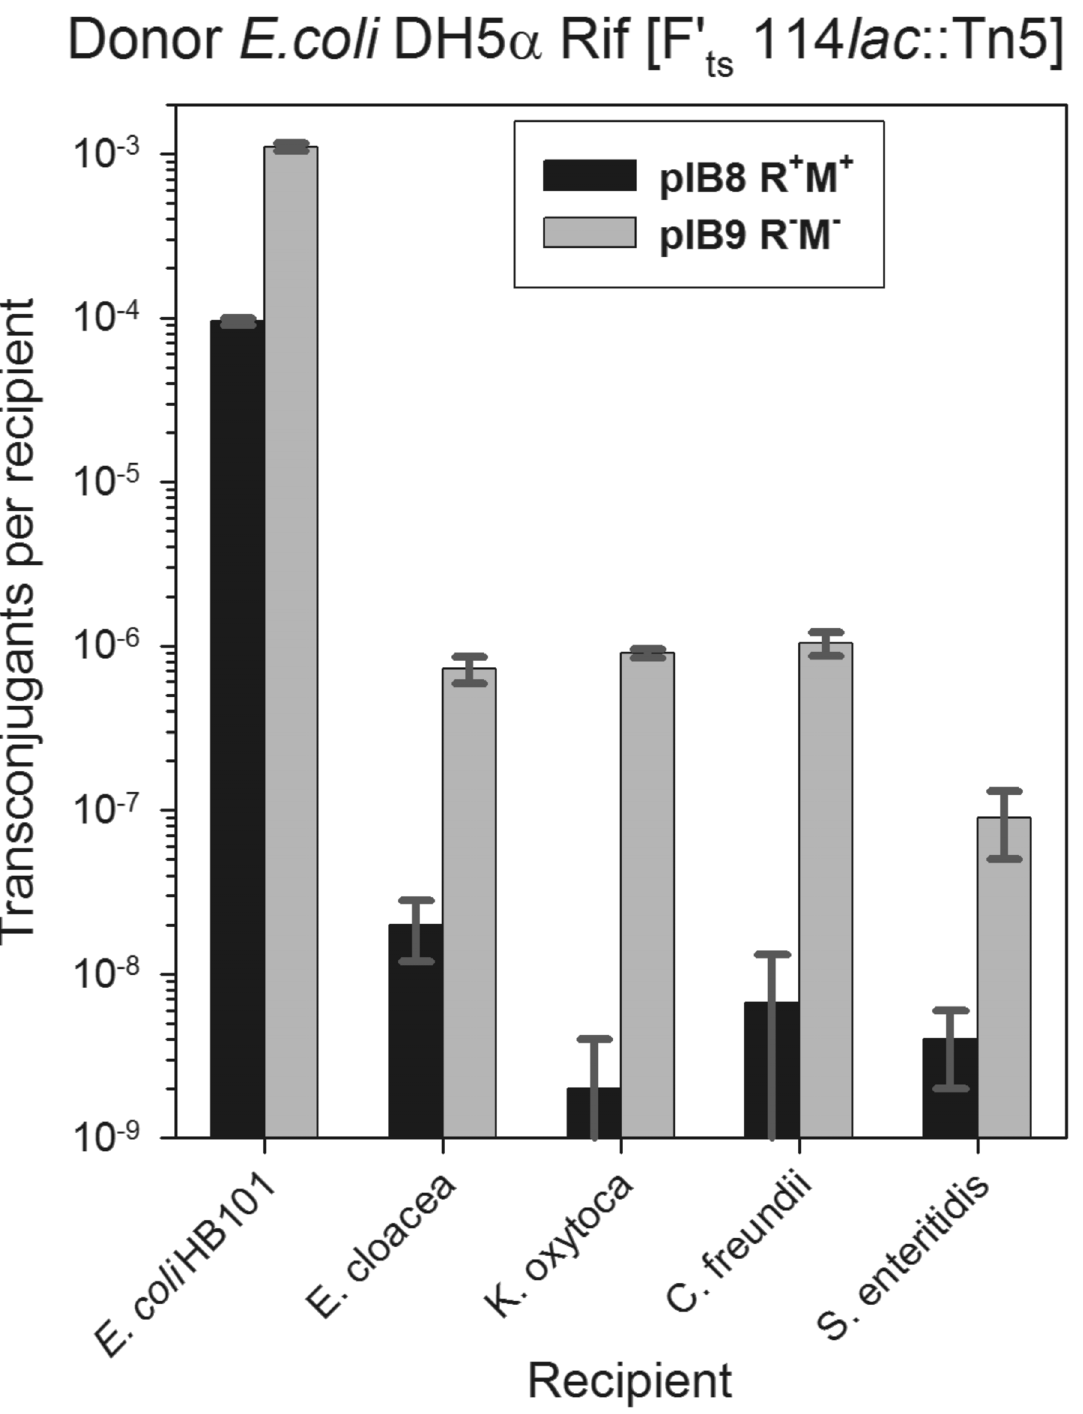
Fig 2. The effect of the presence of EcoVIII RM system in recipient cells on efficiency of conjugal transfer of plasmid F. E . coli DH5 α Rif [F ’ ts 114 lac :: Tn 5 , Km R ] was used as donor. The following recipient bacteria were assayed: Escherichia coli HB101, Enterobacter cloacae , Klebsiella oxytoca , Citrobacter freundii , and Salmonella enteritidis that carried either pEC156-derivative pIB8 (EcoVIII R + M + , black bars) or pIB9 (EcoVIII R − M − , grey bars). Each column represents the mean value ( ± standard deviation) from three repeats. Statistical analysis revealed correlation between presence of a plasmid with RM system in the recipient bacteria and frequency of F plasmid conjugal transfer ( P < 0.0007 for E . coli , E . cloacae , K . oxytoca , C . freundii ; and P = 0.02 for S . enteritidis ; Student t test).